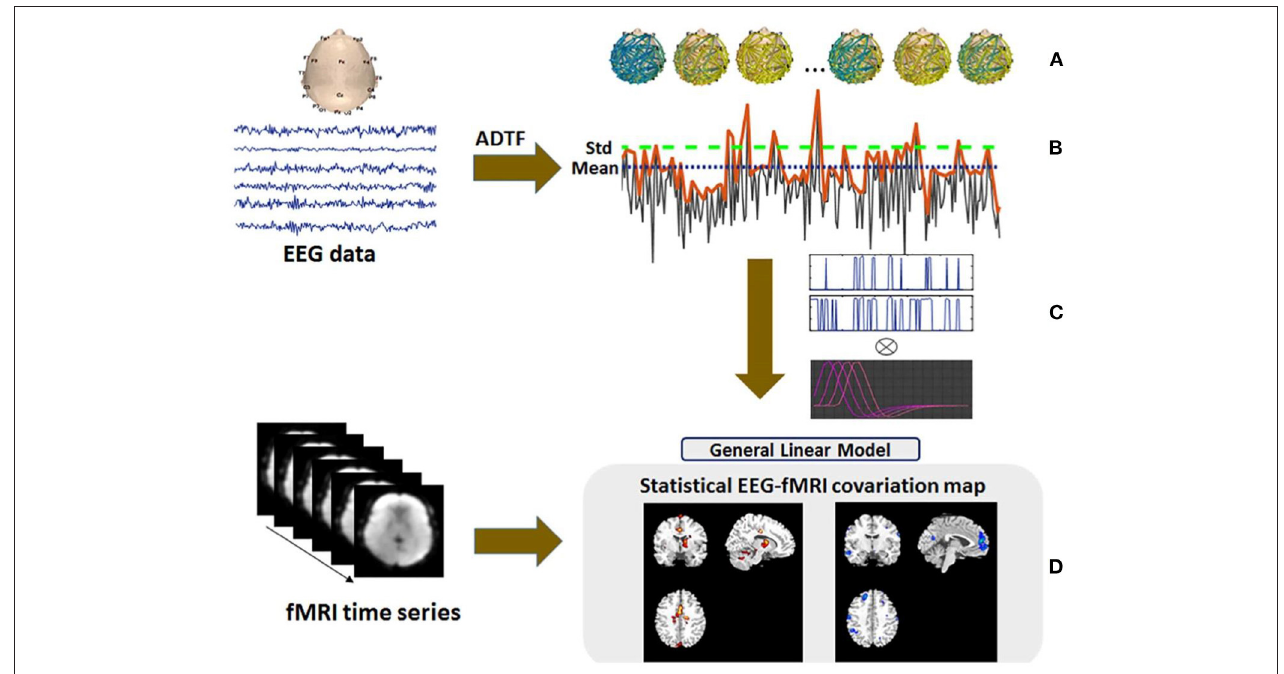
FIGURE 16 | An overview of the suggested EEG–fMRI analysis. (A) After preprocessing the EEG signal, the time-varying scalp network was constructed using ADTF. (B) The variation of the ADTF information flow between electrodes in each 2-s time window was extracted for the generation of network variation time series. (C) The significant values of network variation time series exceeding one standard deviation and the mean were selected as the regressors and added to the GLM analysis, respectively. (D) The results were acquired from the GLM analysis